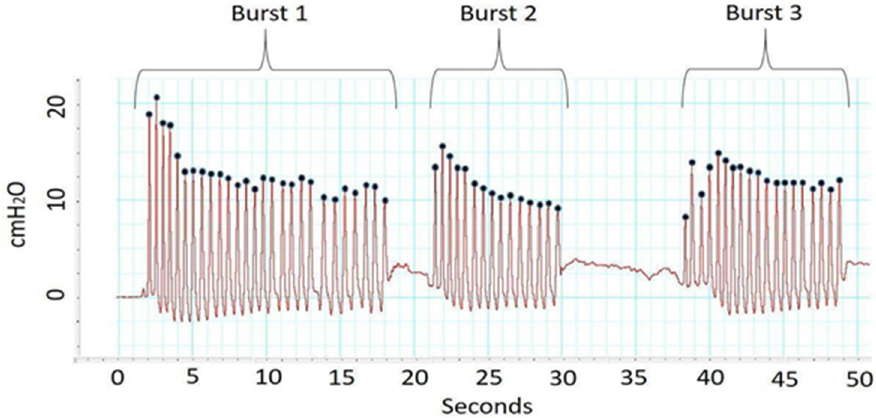
Fig 1. Example Non-nutritive suck (NNS) bursts: Infant NNS is arranged in bursts of sucking with pause periods for respiration. Each burst contains cycles within it, which are depicted as black dots in this image. The frequency (Hz) within a burst is measured by the number of cycles per second. The strength of the suck cycle, or amplitude (cmH20), is measured by examining the top of each cycle where the black dot is located. This image depicts 50s of NNS data with 3 NNS bursts. Burst 1 has 27 cycles/burst (burst duration of 16 sec), Burst 2 has 15 cycles/burst (burst duration 8 seconds) and Burst 3 with 19 cycles/burst (burst duration 11 seconds). Amplitude of each cycle (black dot) can be determined looking at the